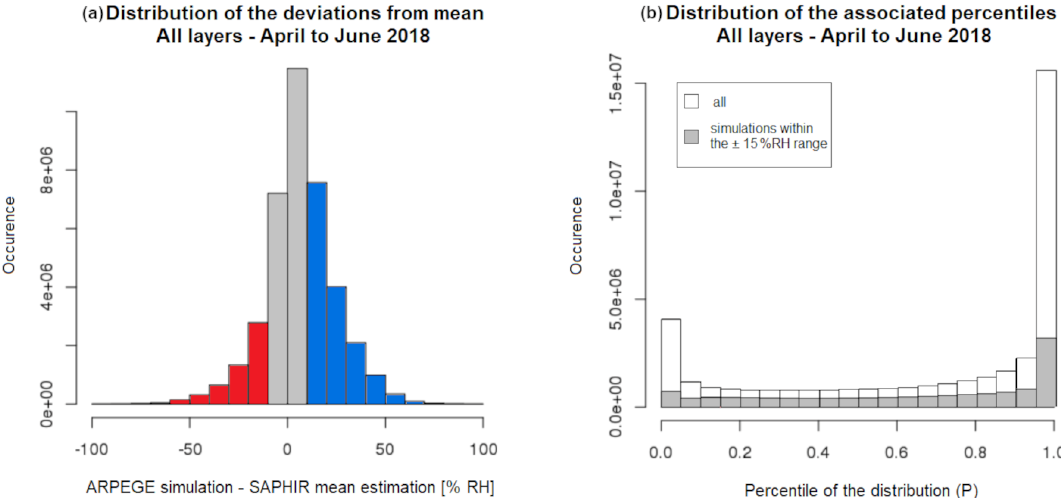
Figure 6. Distribution of the results from each comparison method applied to all layers over the period April to June 2018: (a) histogram of the deviations D from the mean (in red: D < − 15%RH; gray: − 15%RH ≤ D ≤ 15%RH; blue: D > 15%RH) and (b) rank histogram diagram, also known as a Talagrand, of P (in gray: values of P when D is within [ − 15, 15] %RH; in white: for all values of D